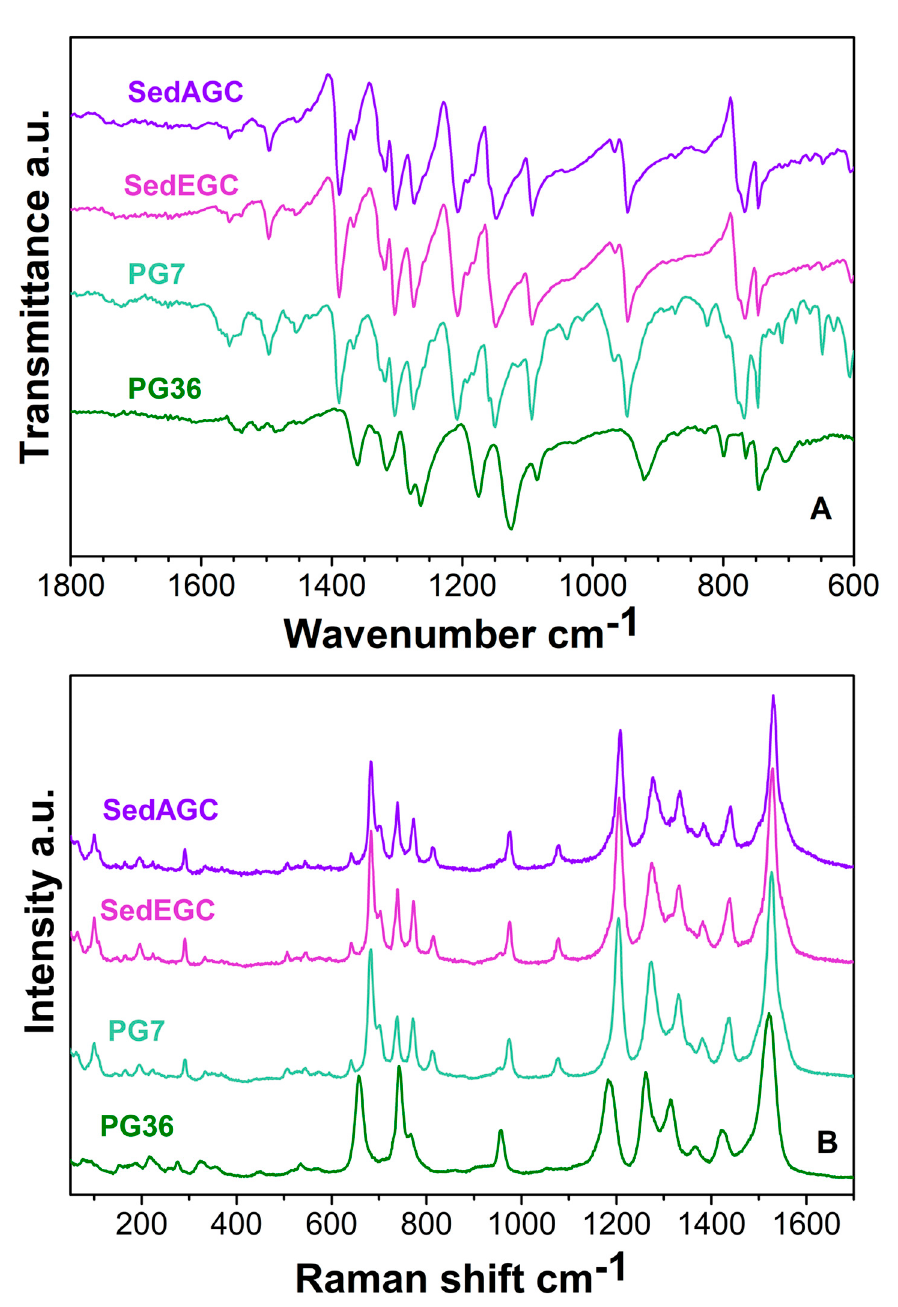
Figure 1. Analysis of the solid residue of Asian (SedAGC) and European (SedEGC) compared to the pigments PG7 and PG36. ( A ) IR spectra and ( B ) Raman spectra.